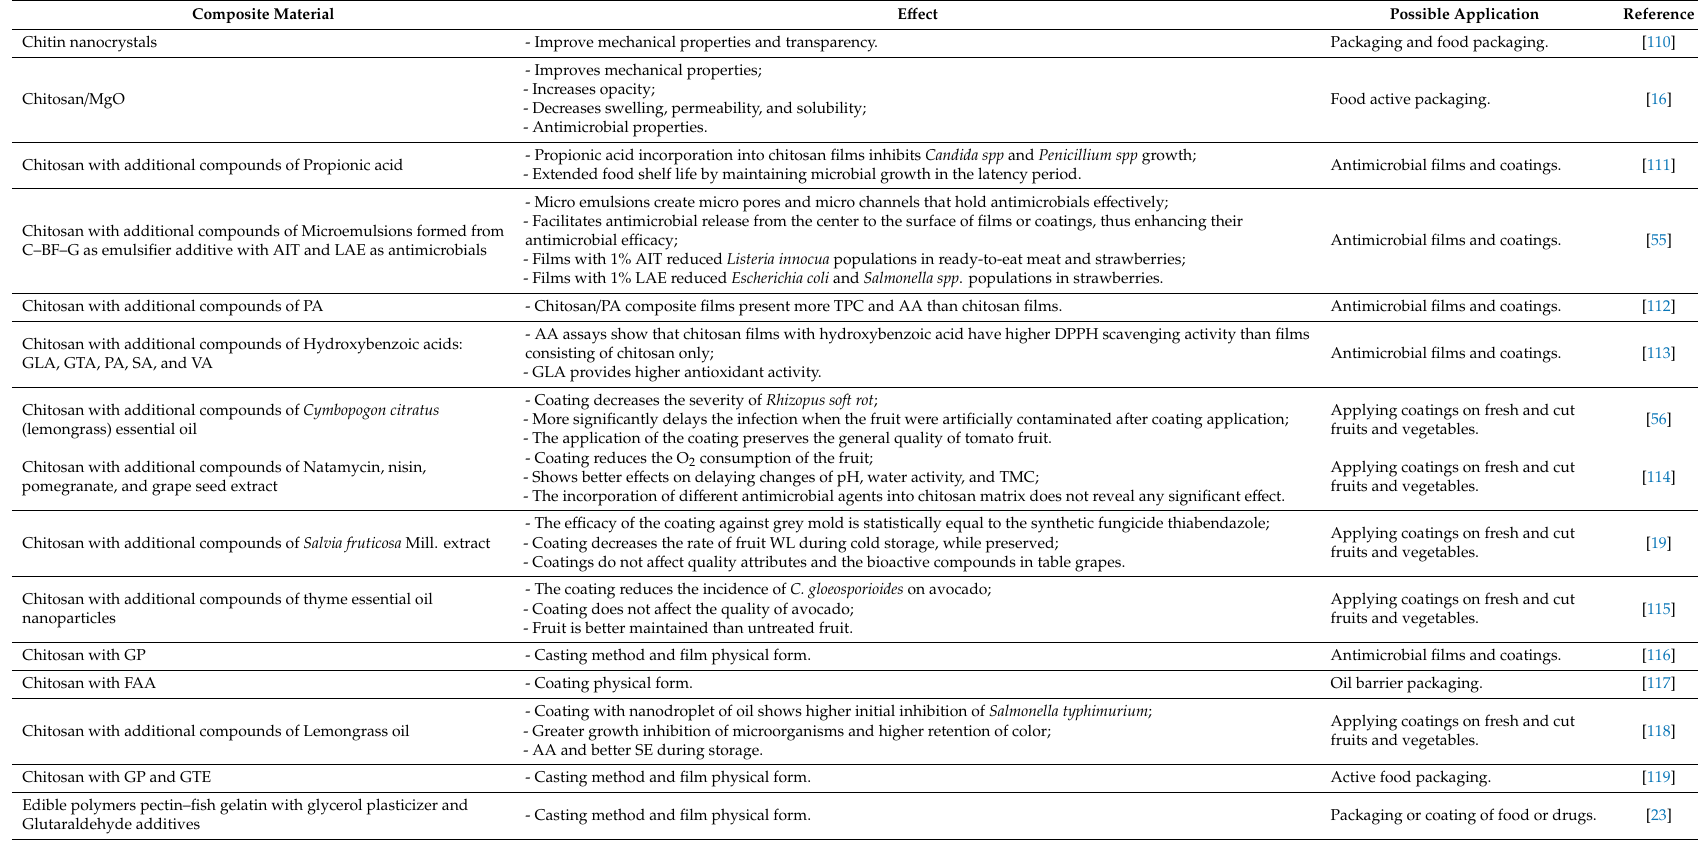
Table 1. Chitosan properties used for di ff erent